Question: Sum up the contents of this chart in one sentence.
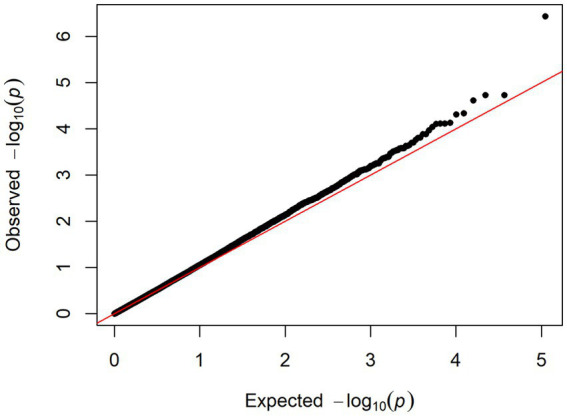
Answer: QQ plot of observed vs. expected p -values for cervicovaginal pH genome-wide association study of Dohne Merino ewes immediately post-CIDR, sponge, or control treatment.